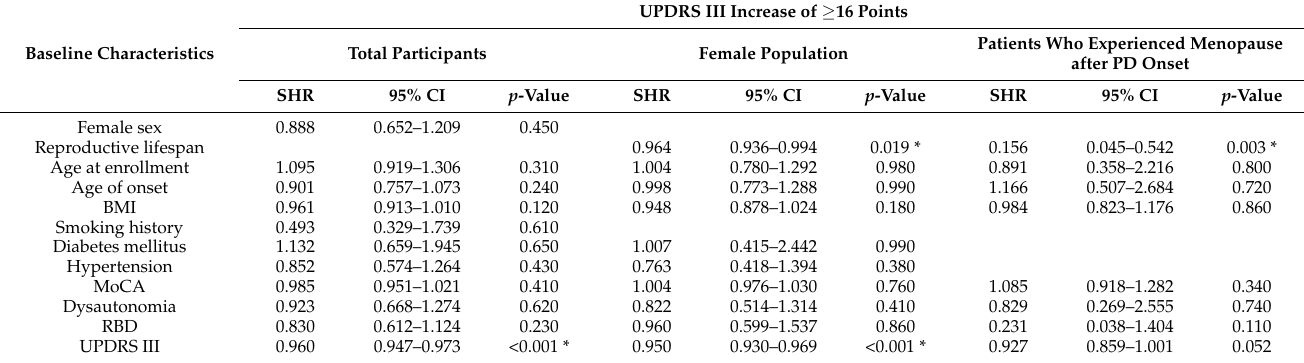
Table 2. Multivariable competing risk analysis for faster motor progression in